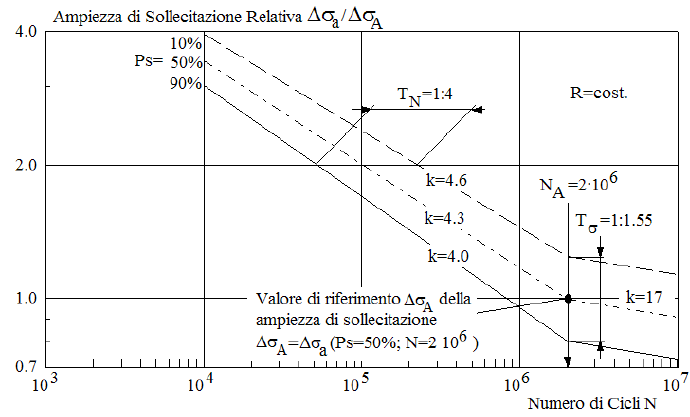
Figura 1: Banda di dispersione relativa alle giunzioni saldate in lega leggera